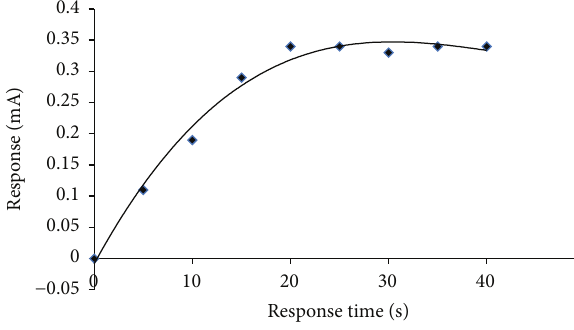
Figure 7: Effect of pH on current response of the present method.